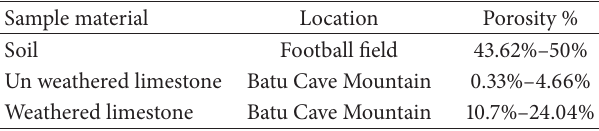
Table 1: Porosity of earth materials from the study area. Table 2: Electrical resistivity of earth materials from the study area.